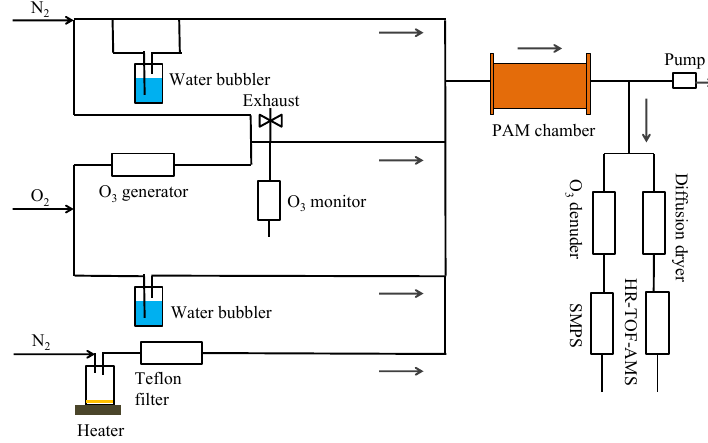
Figure 2. Schematic of the experimental